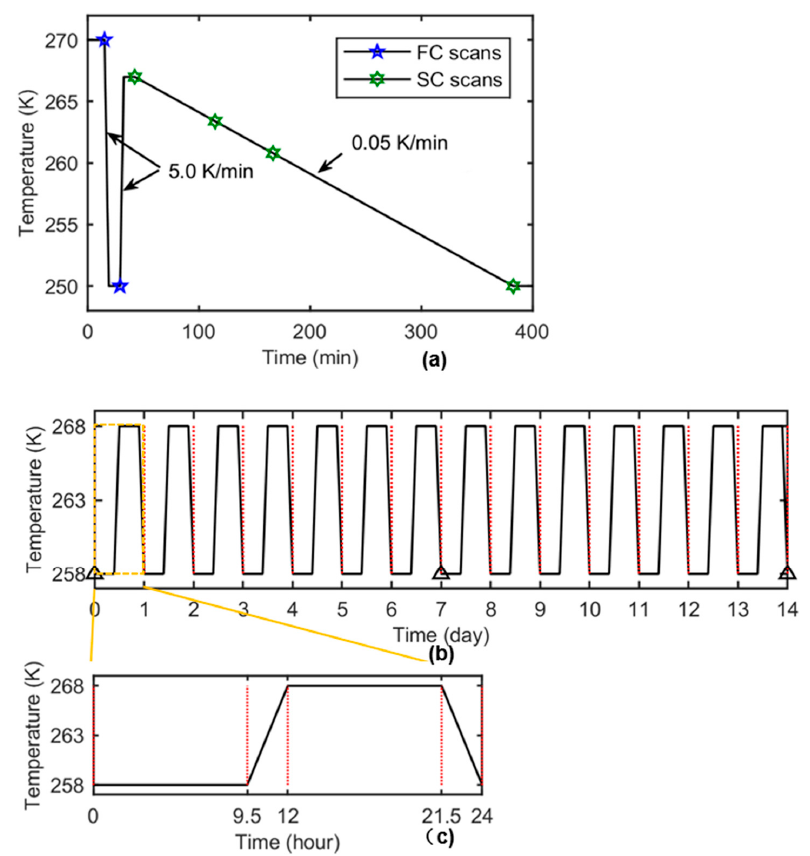
Figure 3. The thermal history of the samples during the in situ and ex situ experiments. ( a ) The overall thermal history of the in situ ice cream samples; the temperature points where the tomographic scans were reconstructed are indicated as blue pentagon and green hexagon markers. For FC, the images were reconstructed at 270 K and 250 K (blue pentagons). For SC, the reconstructed images were obtained at 266.8 K (SC0), 263.4 K (SC1), 260.8 K (SC2), and 250 K (SC3) (green hexagons). The cooling rates for FC and SC are 5.0 K/min and 0.05 K/min, respectively. ( b ) The overall thermal history of the ex situ ice cream samples, with triangular markers indicating the positions where the ice cream samples were extracted and scanned. ( c ) The zoom-in thermal profile showing a single ex situ thermal cycle.